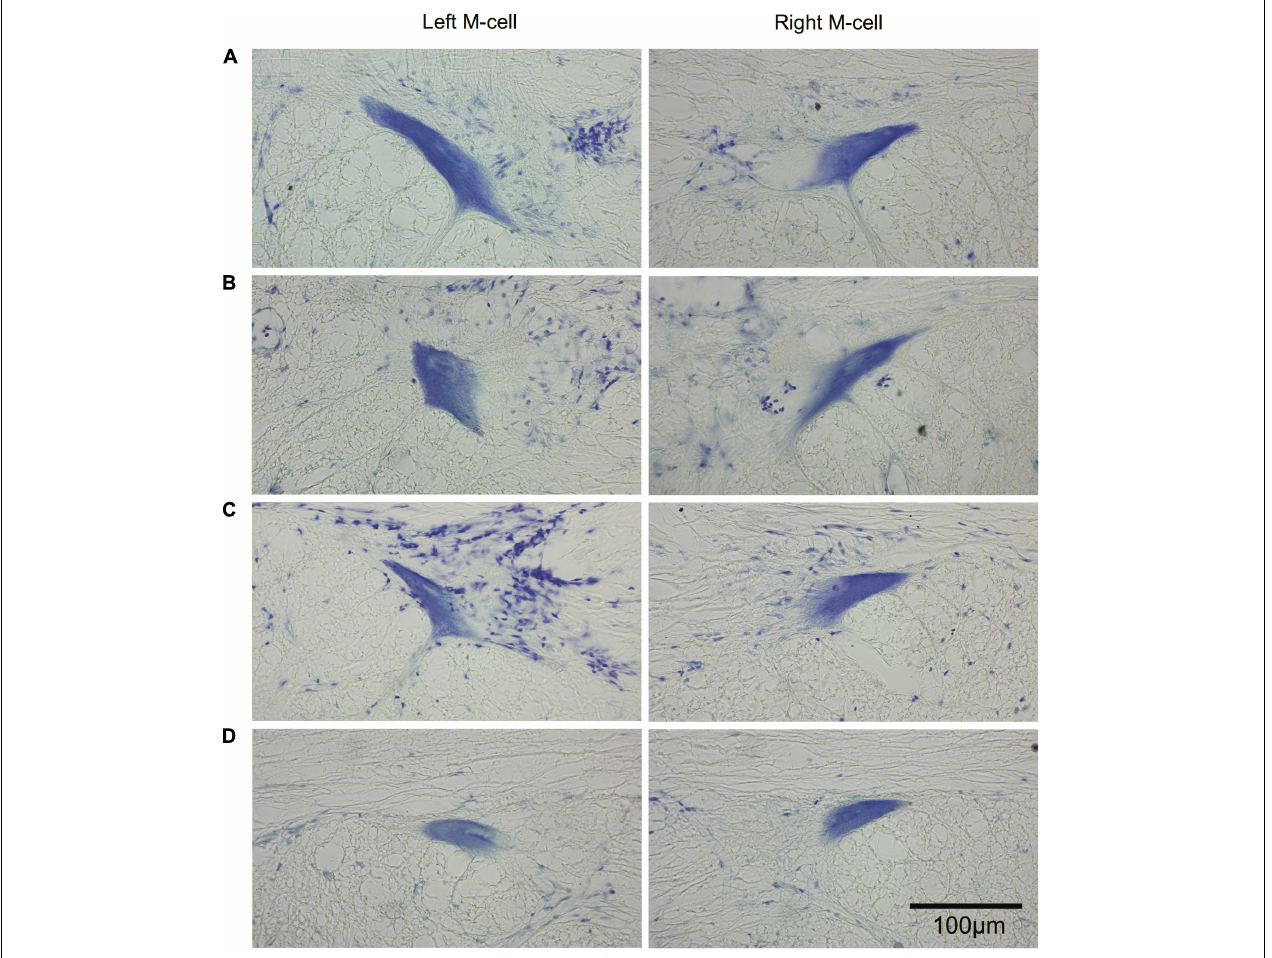
FIGURE 11 | Long-term survival of the Mauthner cell after spinal cord crush. Cross sections (15 µ m) of left and right M-cell somata for fish that have undergone SML crush with post-injury startle responses. (A–D) Left and right M-cells are presented for four experimental fish 198–214 days postoperatively that were used in the EMG studies. Sections are stained with cresyl